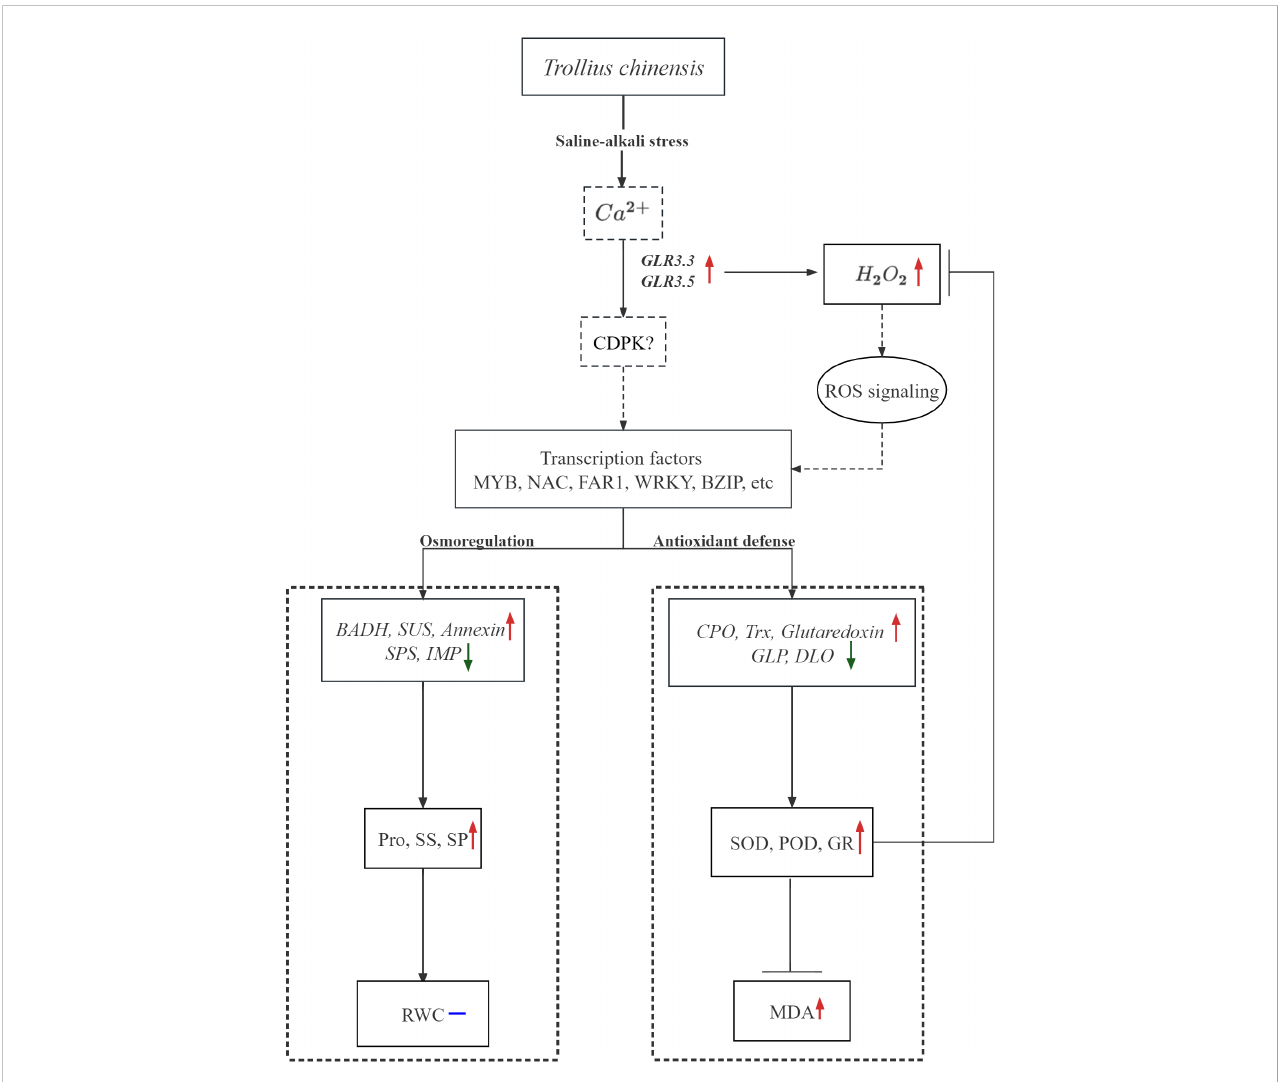
FIGURE 11 The work model of Trollius chinensis in response to low saline-alkali stress (MSA1, 40mM). Red arrows indicate genes with increased expression or substances with increased content or activity, green arrows indicate genes with decreased expression or substances with decreased content or activity, and blue dash line represents that the content of certain substance was not